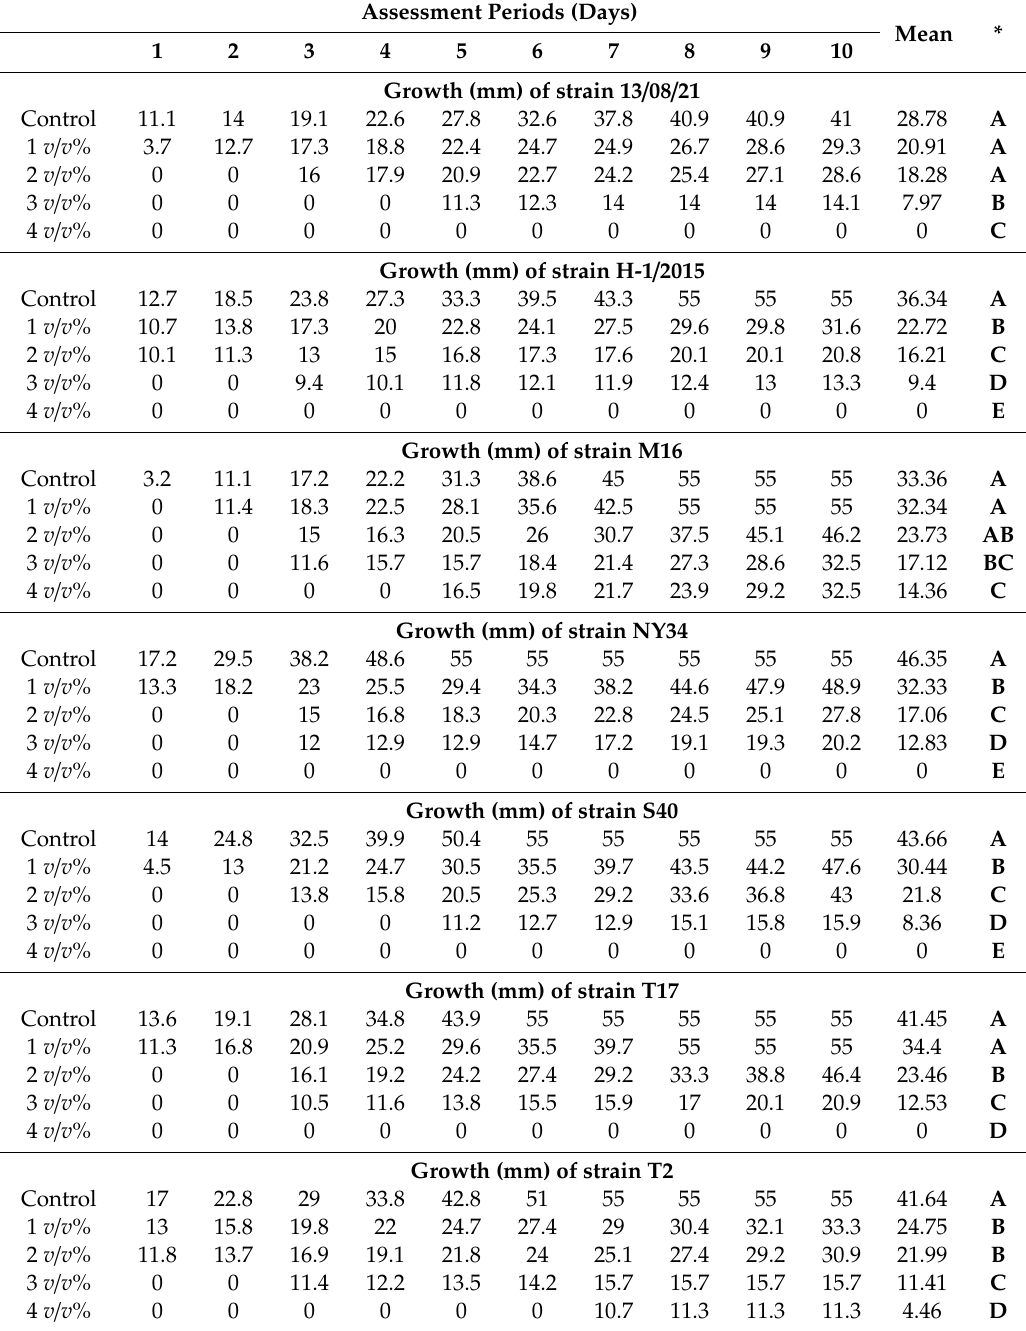
Table 2. Growth (mm) of di ff erent late blight strains treated with 1, 2, 3 and 4 v / v % populin and distilled water (control) during the 10-day assessment period for 20 plates / strains / treatments. Assessment Periods